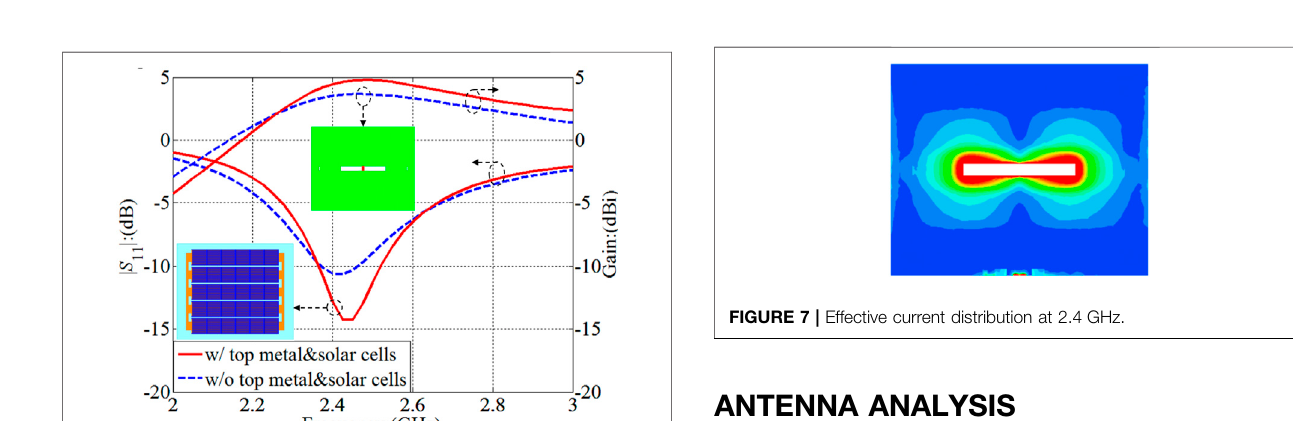
FIGURE 4 | The Z -parameter of the dual-band solar cell antenna.